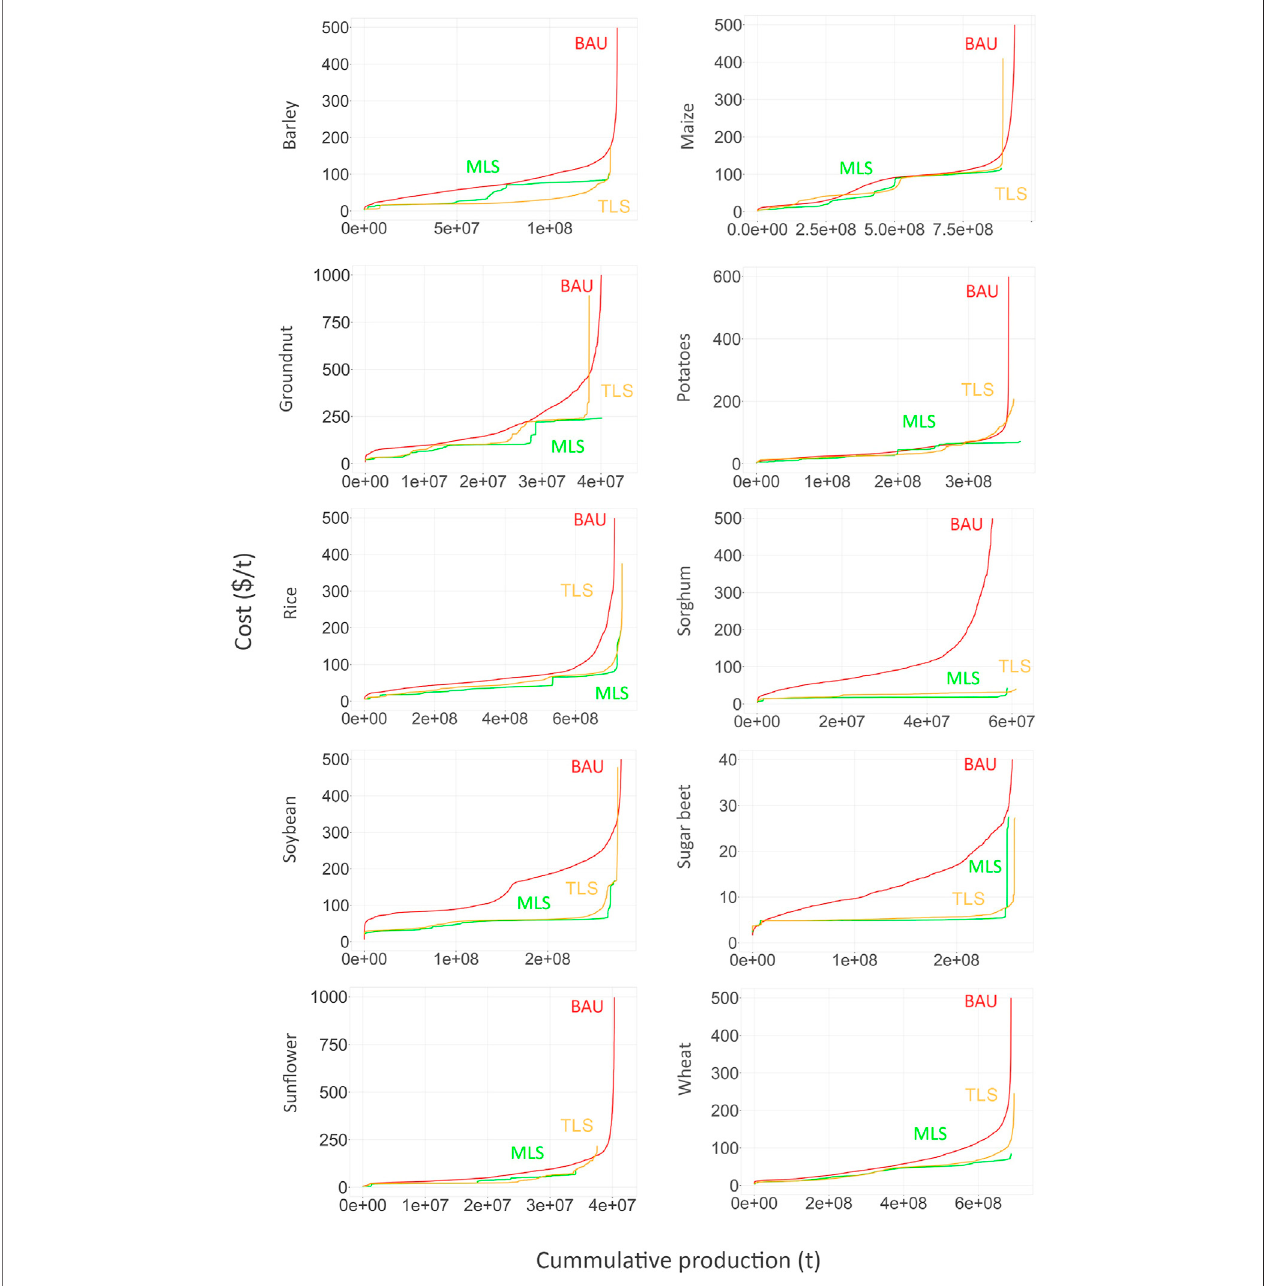
FIGURE 5 | Supply Curves for the 10 crops around the years 2011 – 2015. The graphs illustrate supply curves representing cumulative production per simulation unit, expressed intonnes ( t ,horizontal axis)and the corresponding costs ( $/t ,left vertical axis)under BAUand thetwoland-sparingproduction scenariosforeach ofthe crops under